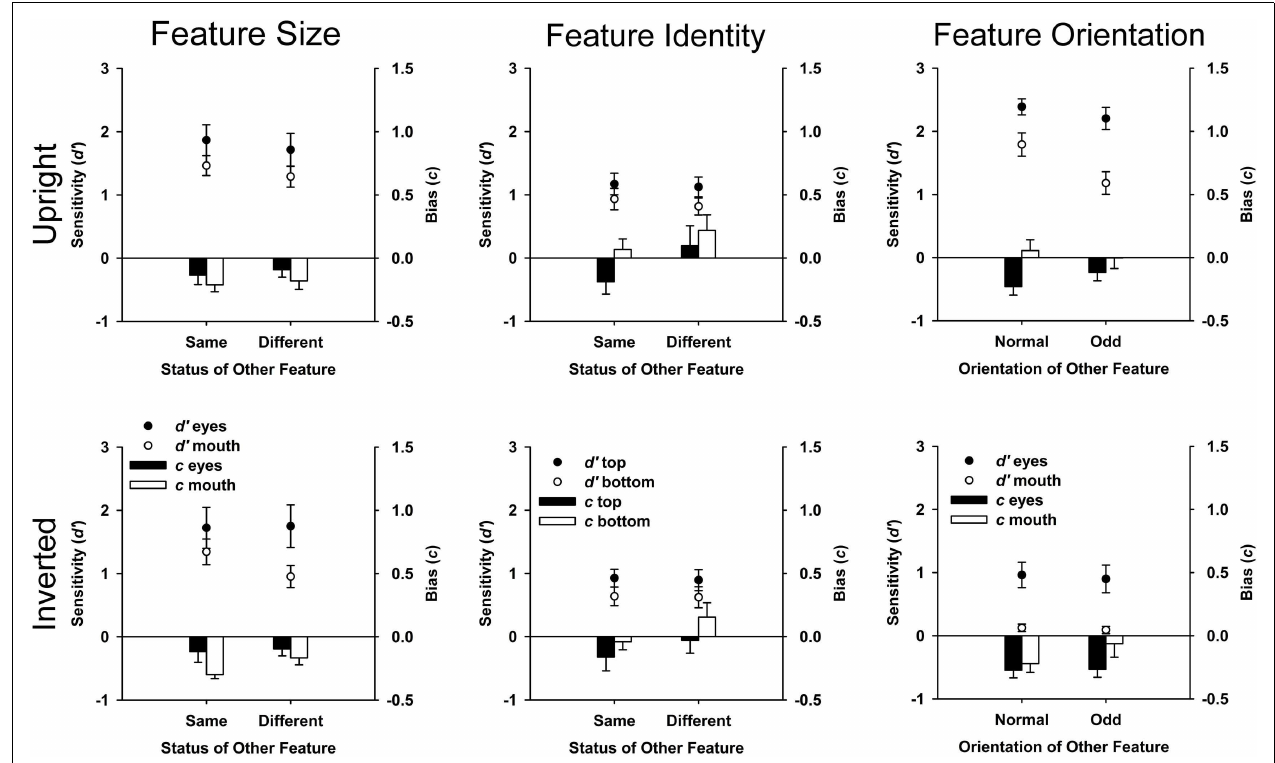
(Feature Size and Feature IdentityTasks) or “normal” (Feature Orientation Task). Positive bias values indicate conservative bias, where participants are more likely to respond “different” (Feature Size and Feature IdentityTasks) or “odd” (Feature